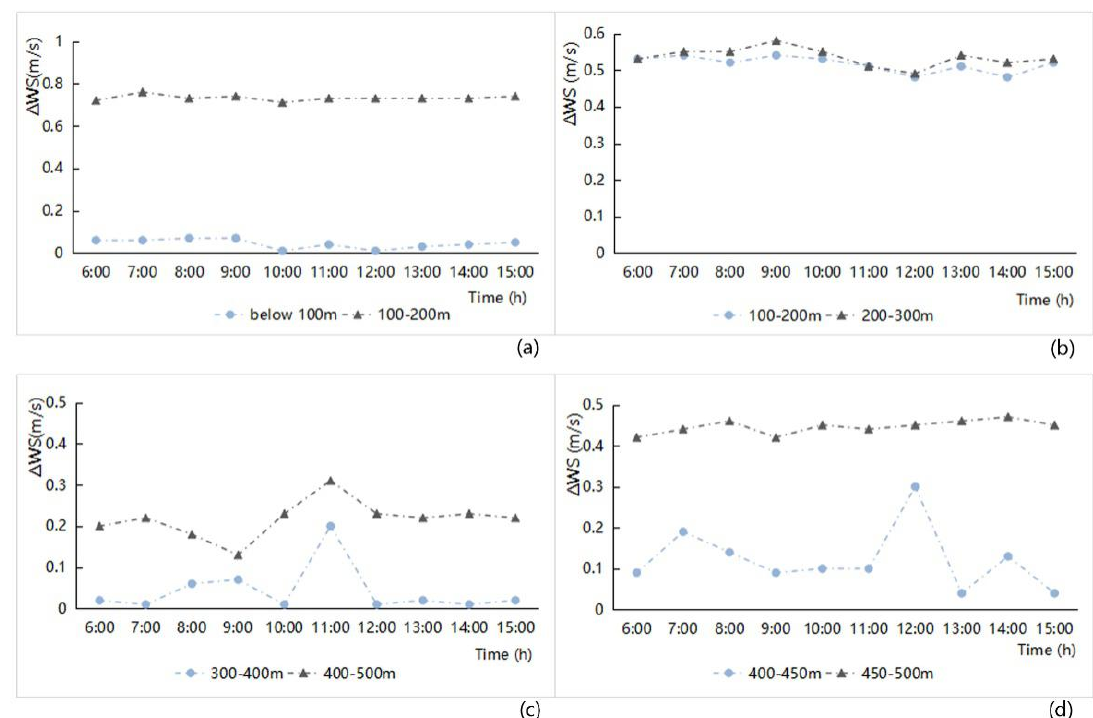
Figure 9. Hourly wind speed difference (ΔWS) variation analysis related to different grade junction spacings of the street network from 6:00 to 15:00 in the four study areas (( a ) Old downtown; ( b ) Gubei international community; ( c ) Anting New Town; ( d ) New Jiangwan Town).